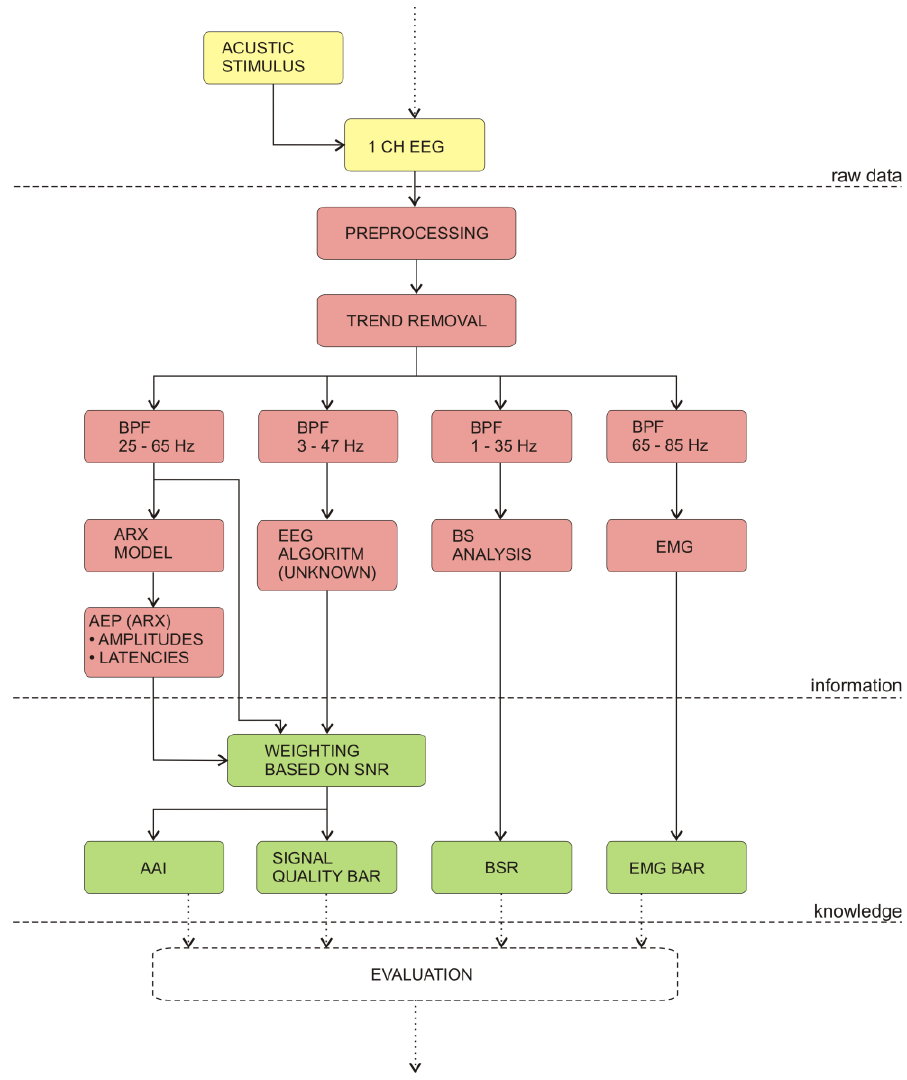
Figure 7. Block diagram of the algorithm of the AEP-monitor/2. Abbreviations: ARX (autoregressive models with exogenous input), BS (burst suppression), BSR (burst suppression ratio), BPF (band pass filter), EMG (electromyogram activity), AAI (AEP-ARXI), SNR (signal  to  noise